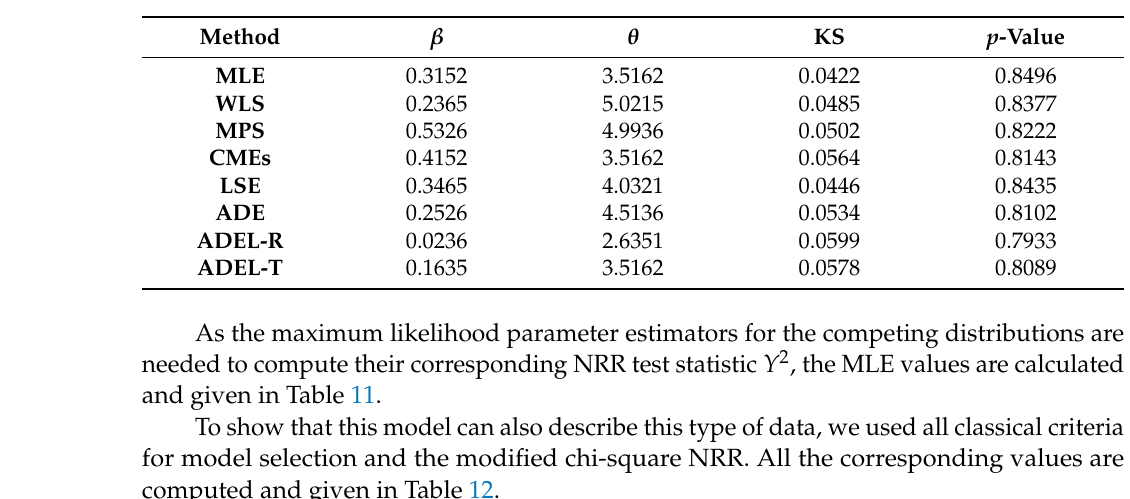
bution PZD obtained by the different methods and the corresponding p -values.